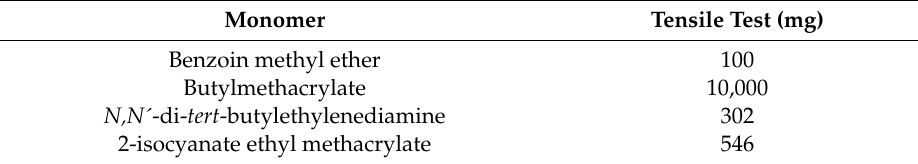
Table 1. The sample composition for the tensile